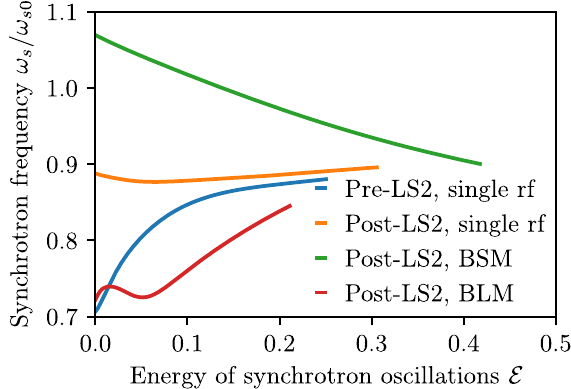
FIG. 19. Synchrotron frequency distributions for different impedance models and rf configurations at the intensity N p ¼ ¼ 1 . 3 2 × 10 11 and the bunch length τ eff